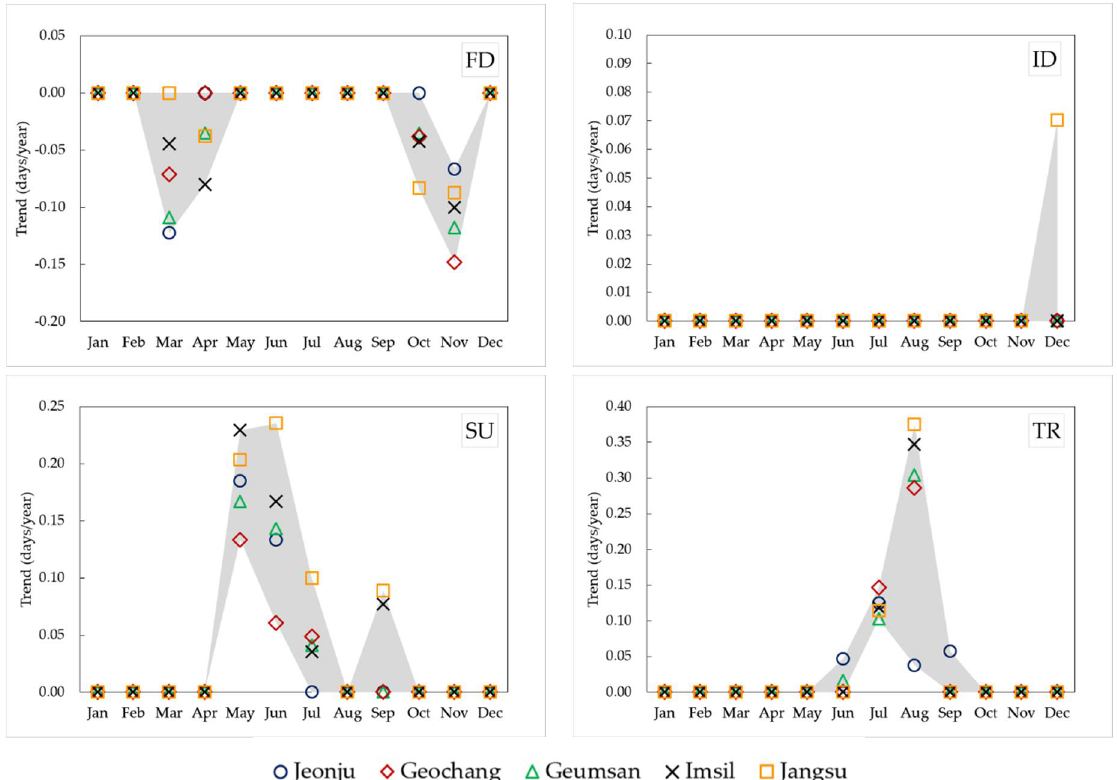
Figure 8. The monthly trend magnitudes of both heat and cold duration indices at the